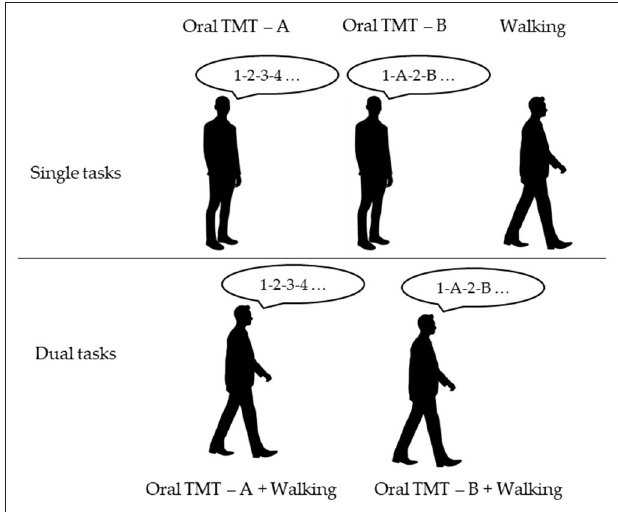
FIGURE 1 | Experimental design of the novel paradigm (TMT-A, Trail Making Test part A; TMT-B, Trail Making Test part